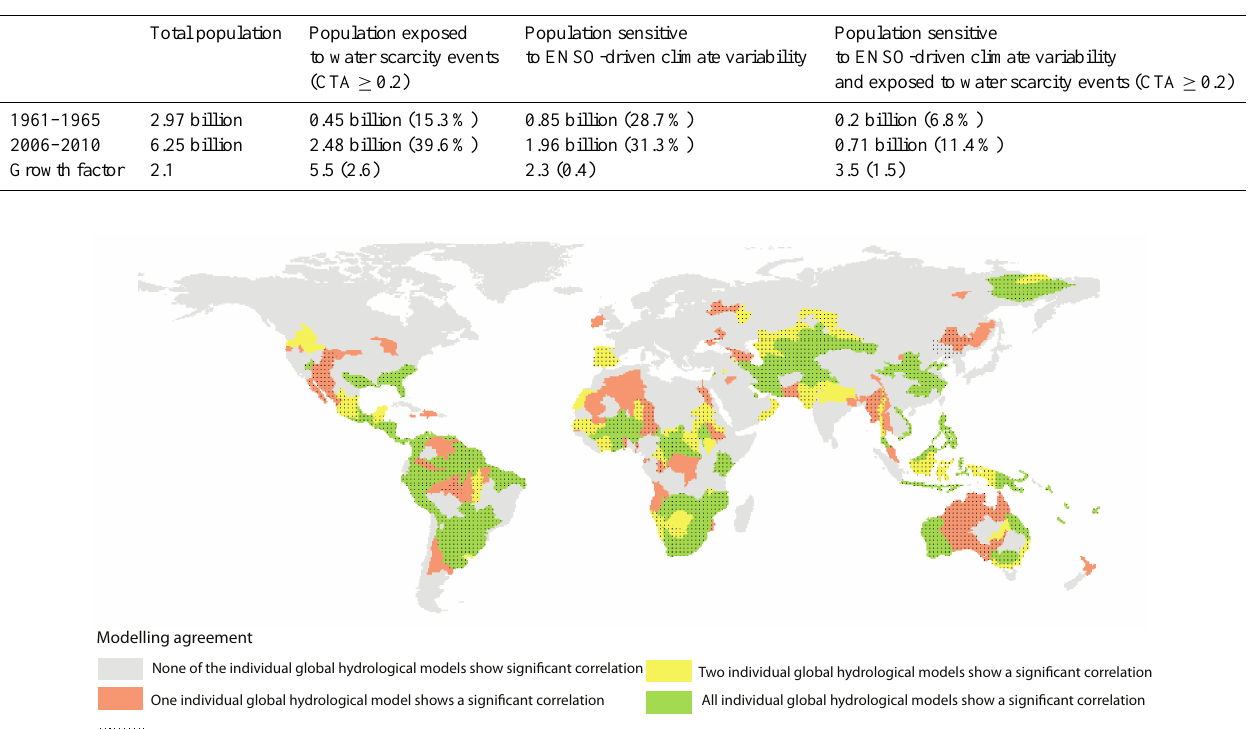
Table 5. Development of (a) the global total population, (b) the global population exposed to water scarcity events (CTA ratio), (c) the global population living in areas sensitive to ENSO-driven climate variability, and (d) the global population being exposed to water scarcity events (CTA ratio) and living in areas sensitive to ENSO-driven climate variability, between 1961 and 2010 using 5-year averaged values. Numbers between brackets show the values expressed in percentage of the total population. Growth factors represent both the absolute increases as well as the relative increases over time.